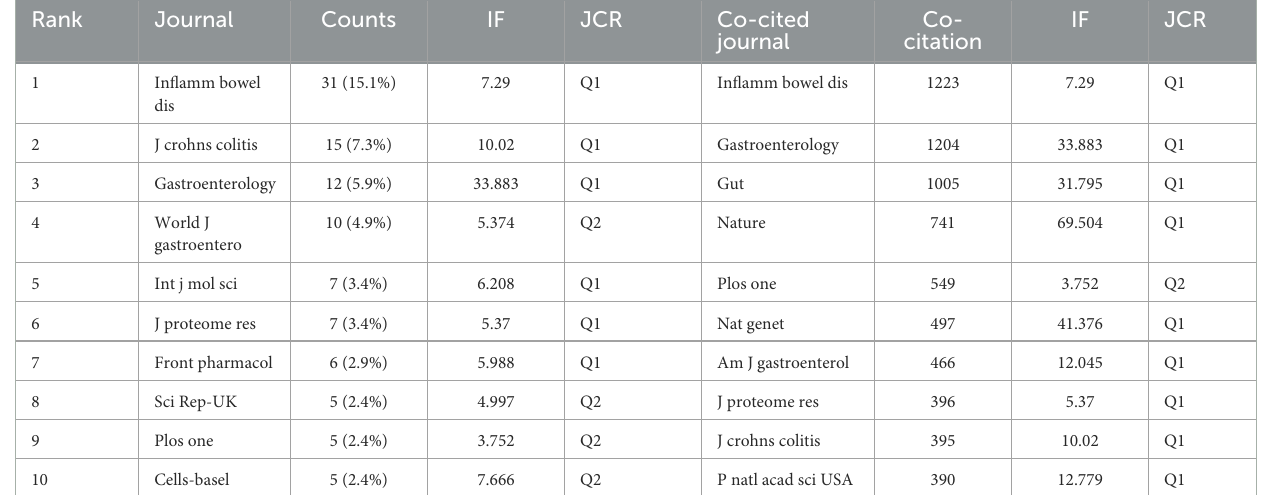
TABLE 3 The top 10 journals and co-cited journals on the research of omics in